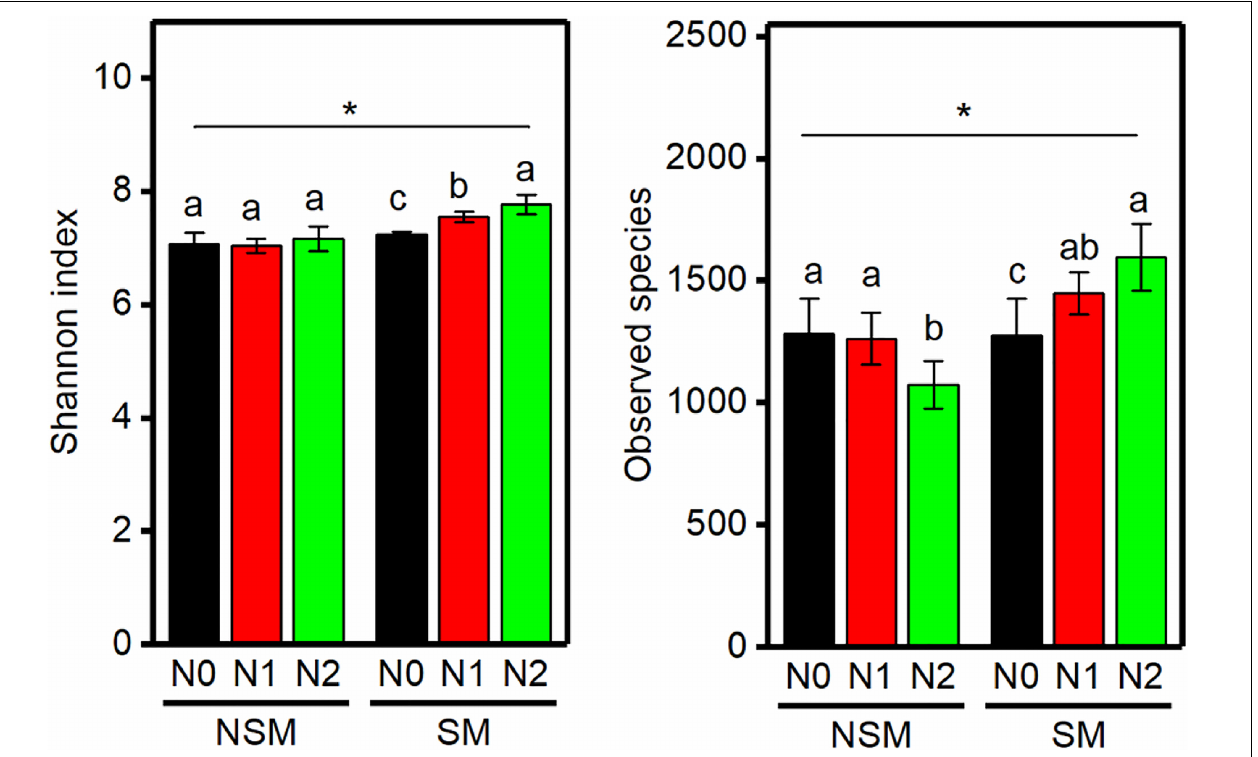
FIGURE 2 | The α -diversity of the diazotrophs in wheat rhizosphere soil under straw mulching and nitrogen fertilization treatments. NSM, no straw mulching; SM, straw mulching; N0, no nitrogen; N1, 120 kg N ha − 1 ; N2, 180 kg N ha − 1 . Data shown as mean ± SD. *indicates statistically significant difference ( P < 0.05) between NSM and SM. Different letters above columns indicate statistically significant difference ( P < 0.05) between N fertilizer levels within NSM and SM.